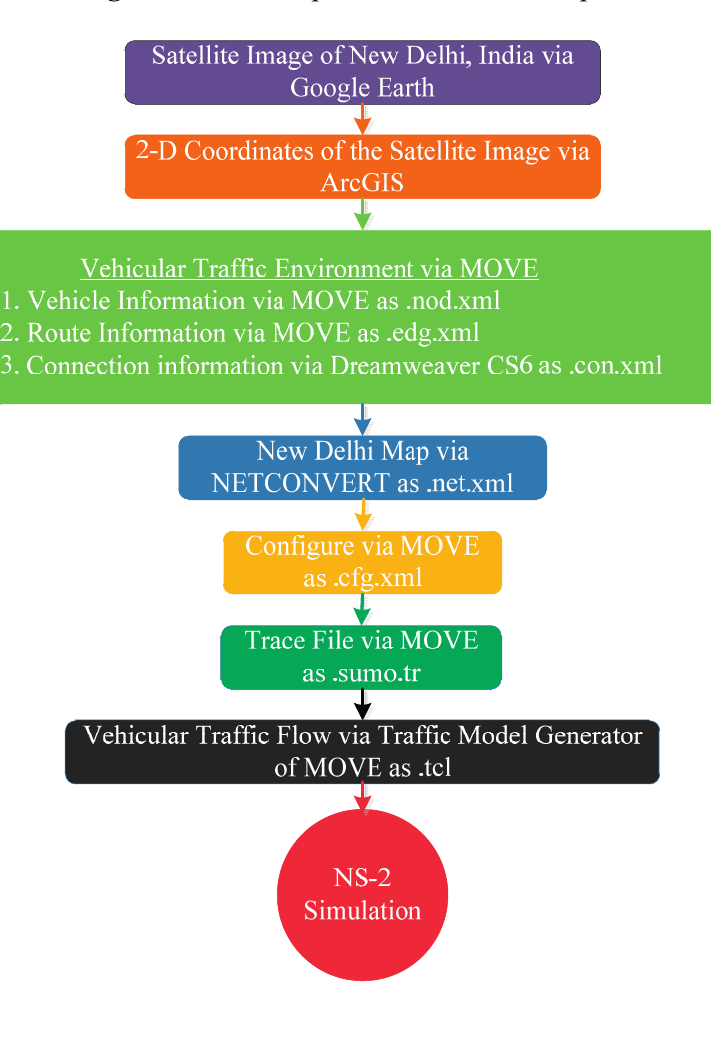
Figure 13. The Map-based simulation